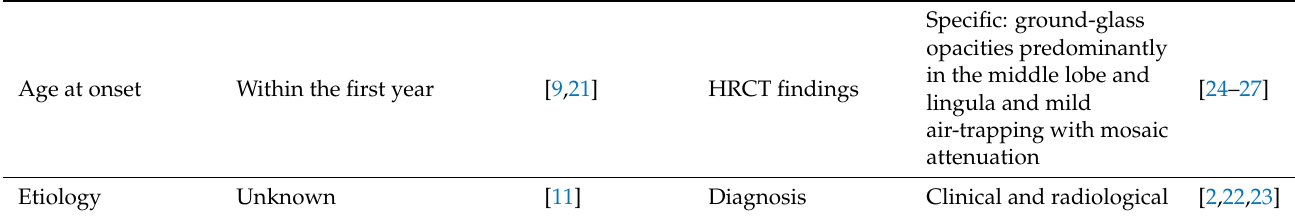
Table 1. NEHI main